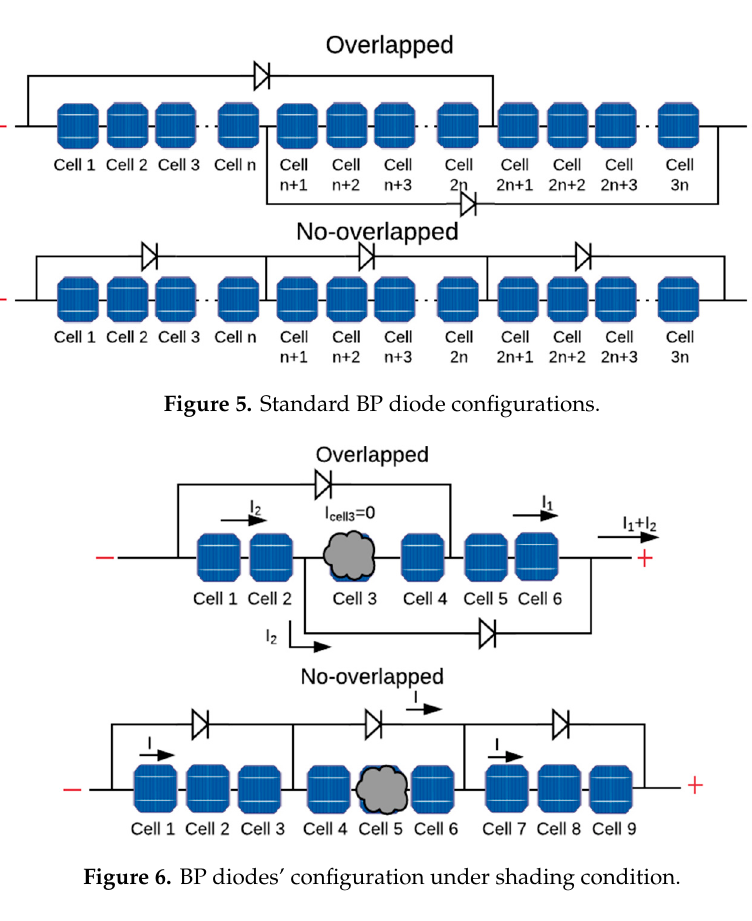
Figure 6. BP diodes’ configuration under shading condition.